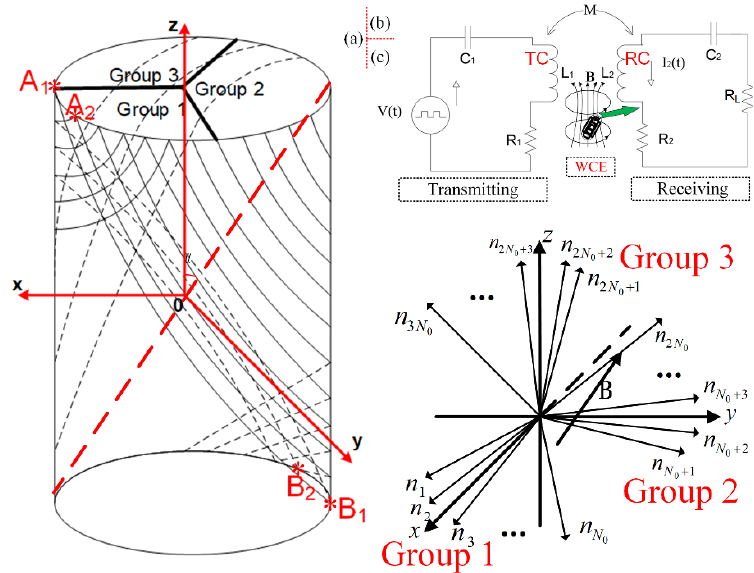
Figure 2. ( a ) Winding of hollow coil; ( b ) equivalent lumped circuit; ( c ) coordinates of normal vectors of each single turn of coil.